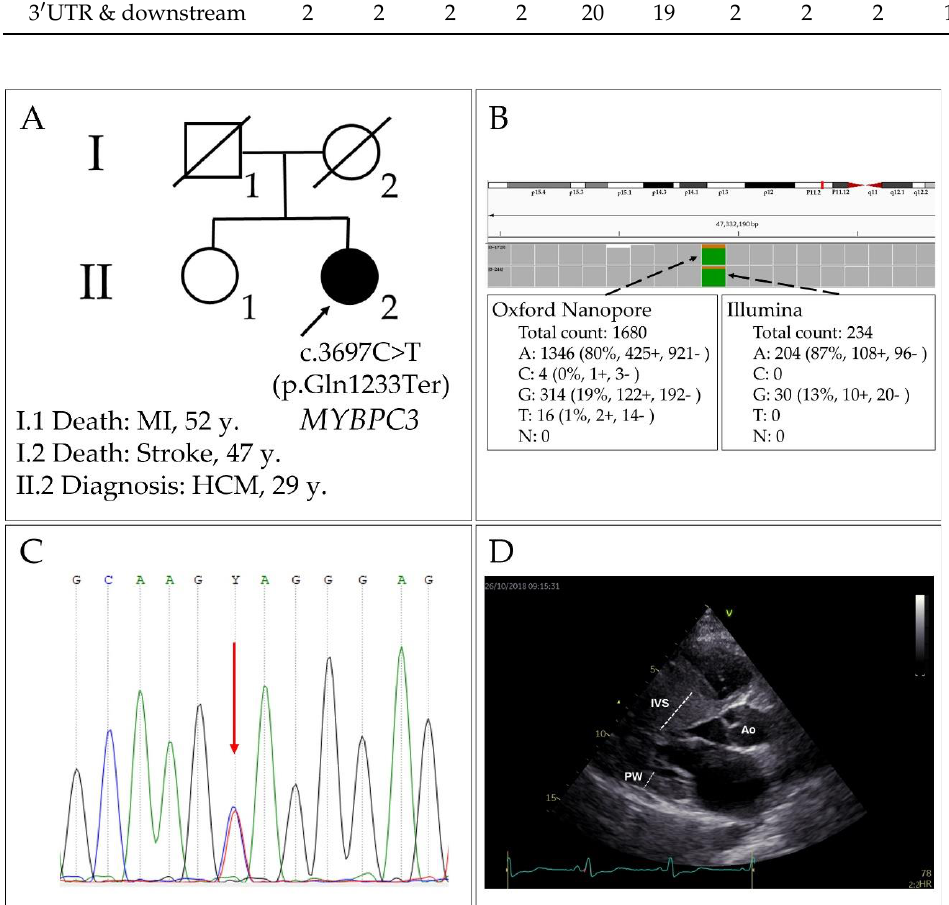
Figure 3. The case of HCM (patient 1) with p.Gln1233Ter (rs397516037) in the MYBPC3 gene. ( A ) The pedigree of the proband (MI: myocardial infarction); ( B ) molecular genetic testing of the patient by ONT and Illumina methods; ( C ) Sanger sequencing; ( D ) echocardiogram: left ventricle, parasternal long axis position. The patient harbouring this variant was a 29-year-old female with an obstructive form of HCM and severe asymmetric left-ventricular hypertrophy (interventricular septal thickness 43 mm; Figure 3D); after this diagnosis (in the past), she had undergone surgical correction of the interventricular septum (IVS). This case is characterised by a severe course of the disease: even after the primary surgical intervention, the patient had shown a repeated increase in IVS thickness and high values of the gradient in the left-ventricular outflow tract. It should be noted that the ONT data analysis indicated that this variant is homozy- gous with 80% of the variant allele, whereas Illumina data identified it as heterozygous with 87% of the variant allele (Figure 3B). Sanger sequencing verified the heterozygous state of the variant. Accordingly, this case indicates that caution should be exercised when genotypes are identified in the ONT data. The genotype “overcall” might be explained by the fact that, since ONT sequencing quality is not perfect, the genotype calling algorithm assigns a homozygous state by default to the dubious genotypes. In addition, we should note that that such a striking allelic bias in the data (for both methods) could result from the presence of other single-nucleotide polymorphisms (SNPs) in the haplotype with the reference allele; therefore, it can lead either to the primer annealing bias in PCR (partial allelic dropout), if located in the primer-annealing zone [19], or to a context-dependent decrease in sequencing/alignment/base-calling quality.